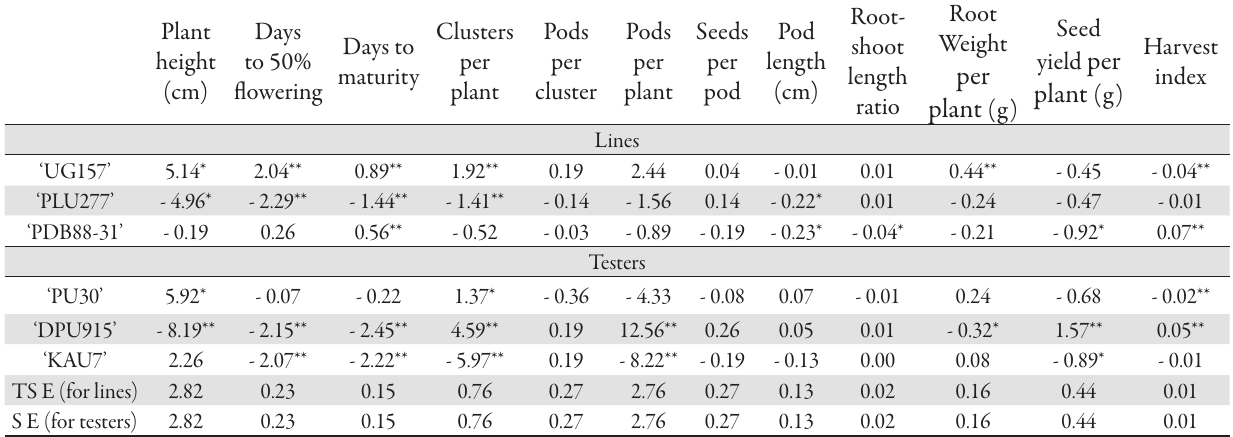
Tab. 4. Estimates of GCA effects of lines and testers in black gram